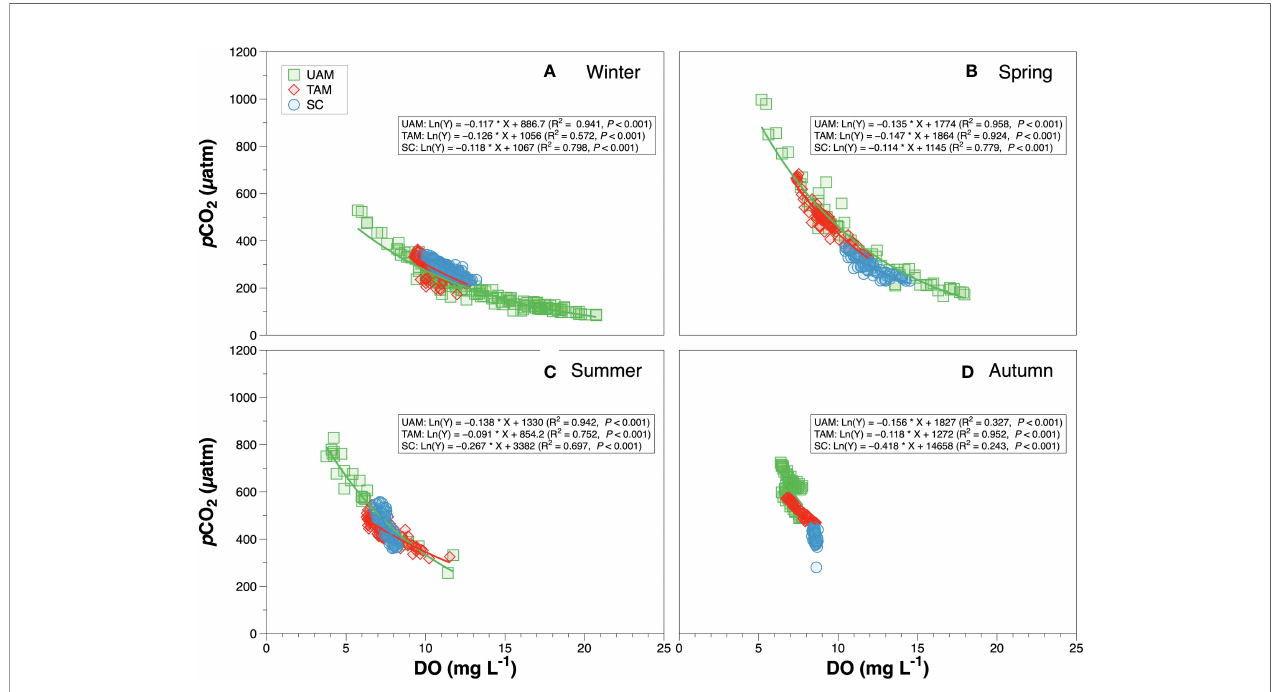
FIGURE 6 | The relationship between p CO 2 and dissolved oxygen (DO) of three macroalgal habitats in winter (A) , spring (B) , summer (C) and autumn (D) . Solid lines are the least square fi tting curves of data using the non-linear exponential regression model. Values for different macroalgal habitats: ulvoid algal mat (UAM, green square); turf algal mat (TAM, red diamond); coexisting Sargassum horneri and crustose coralline algae (SC, blue